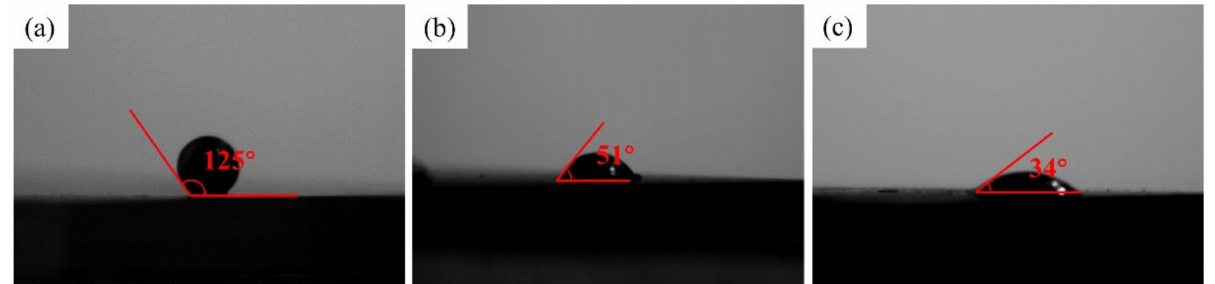
Figure 6. Wetting angles of Sn-Ag solder balls on ( a ) bare sapphire, ( b ) Ni-P plated sapphire and ( c ) bare Cu